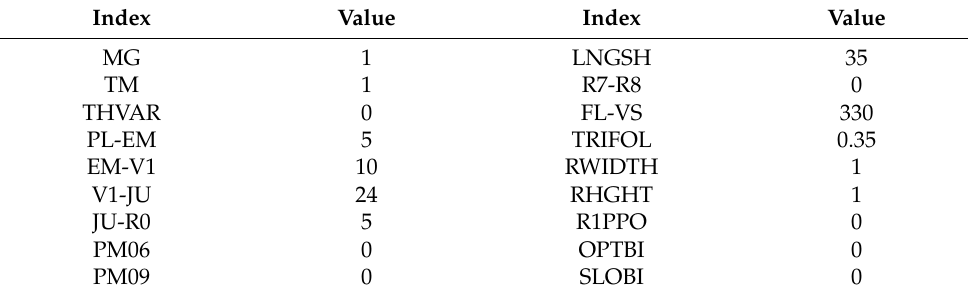
Table 5. Calibrated ecotype coefficients of bell pepper in CropGro-pepper.